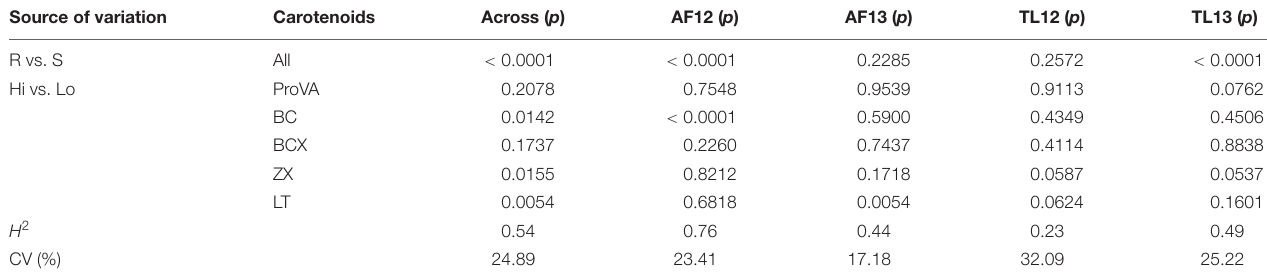
TABLE 4 | Probabilities of significance ( p ) for F -tests for contrasts of hybrids of aflatoxin resistant (R) vs. susceptible (S) testers, and for hybrids with high (Hi) vs. low (Lo) carotenoids concentrations for A. flavus colonization of grain measured by bright greenish yellow fluorescence scores [pFLt, sqrt(pFL)] for analyses of variance at individual and across five trial